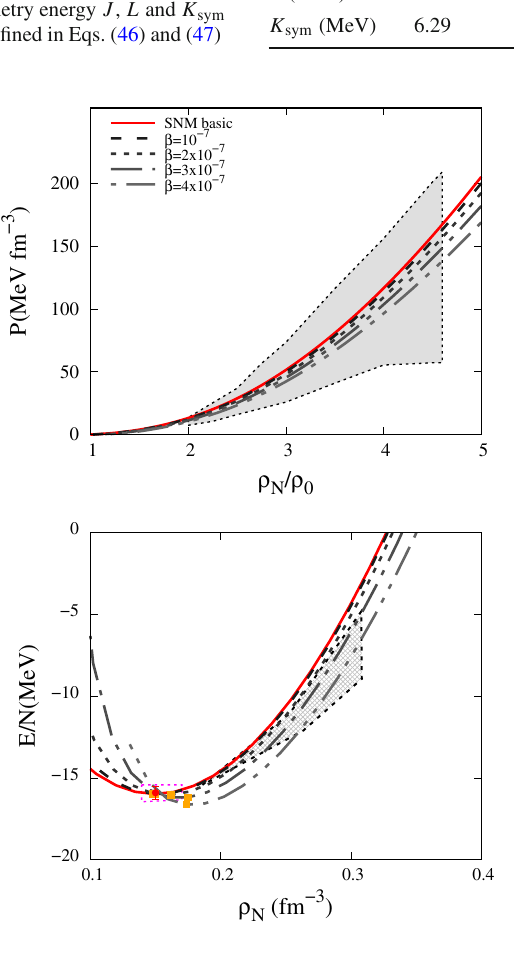
Table 1 Nuclear-matter properties at the saturation density ρ 0 predicted by BSP with various values for β . The Fermi momentum k F , binding energy E / N , incompressibility coefficient for SNM K 0 , symmetry energy J , L and K sym are defined in Eqs. (46) and (47)